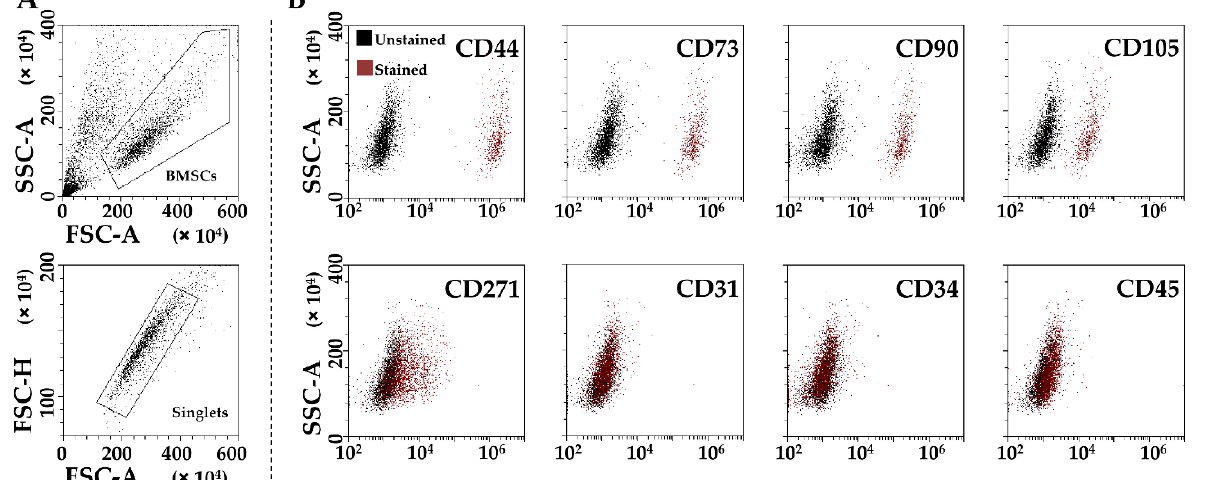
Figure 1. Flow cytometry analysis of BMSCs. ( A ), Identification of single cells by exclusion of debris (upper panel) and aggregates (lower panel). ( B ), staining for general mesenchymal (CD44, CD73, CD90 and CD105, positive), BMSC-specific (CD271, positive) and hemato-endothelial markers (CD31, CD34 and CD45, negative), confirming BMSCs identity. Representative plots are shown.